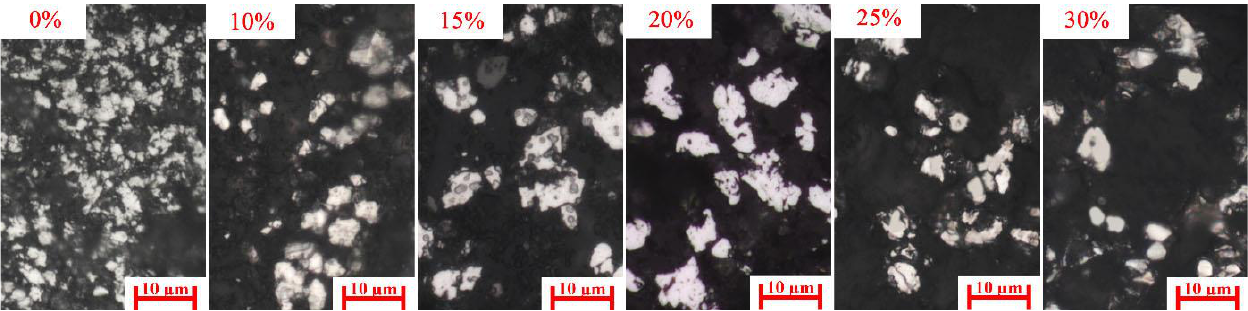
Figure 4. Microstructures of the carburized pellet as a function of Na 2 SO 4 (iron carbide-white).